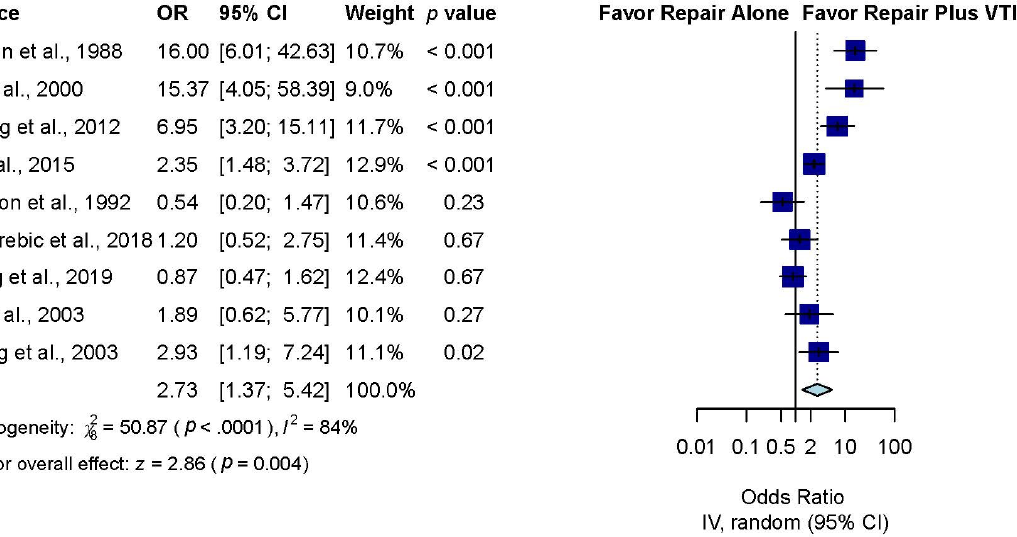
Figure 2. Overall effect of VTI with palatal repair on the otitis media with effusion (OME)-free rate.